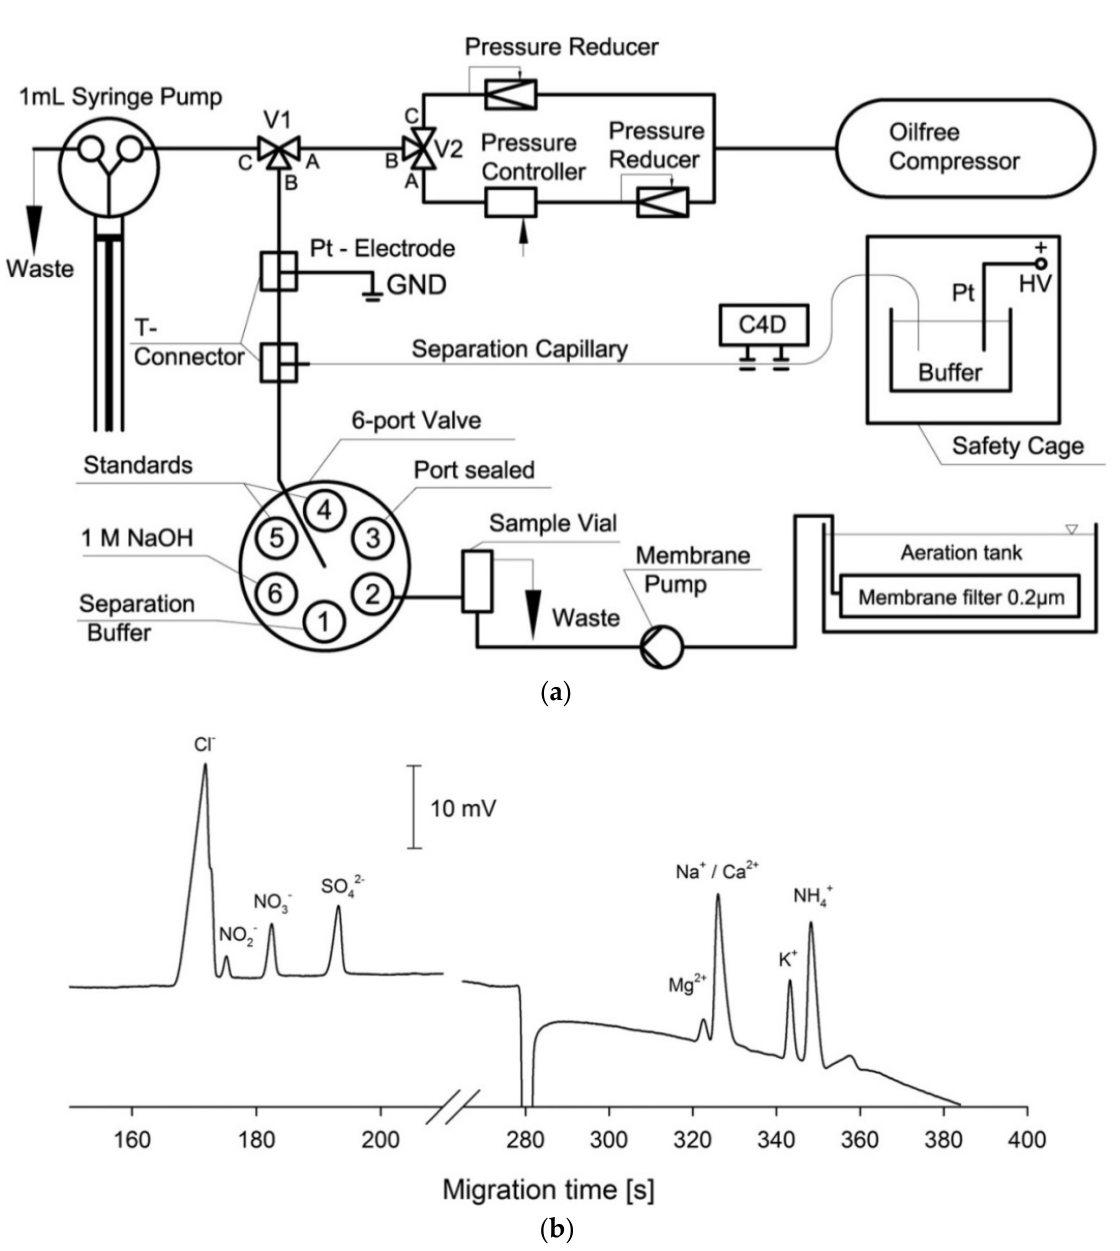
Figure 6. Schematic diagram of a SI-CE system with contactless C 4 D conductivity detection developed for the determination of nitrogen-containing ions ( a ), and sample electropherograms recorded from wastewater samples ( b ) [61]. CE conditions in ( b ): capillary—68 cm, 20 µ m I.D., BGE—100 mM His, 100 mM MES, 0.13 mM CTAB, 1.5 mM 18-crown-6, pH 6, V: +24 kV. (Reproduced under permission from Elsevier. License Number 5173120520906).